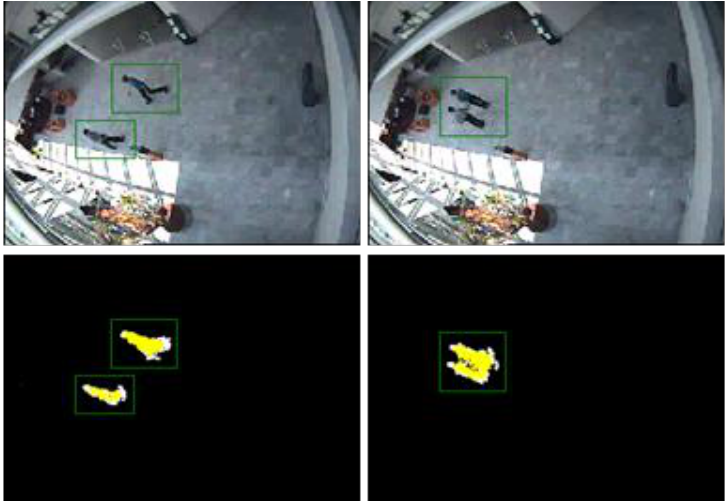
Figure 5. GNG graph